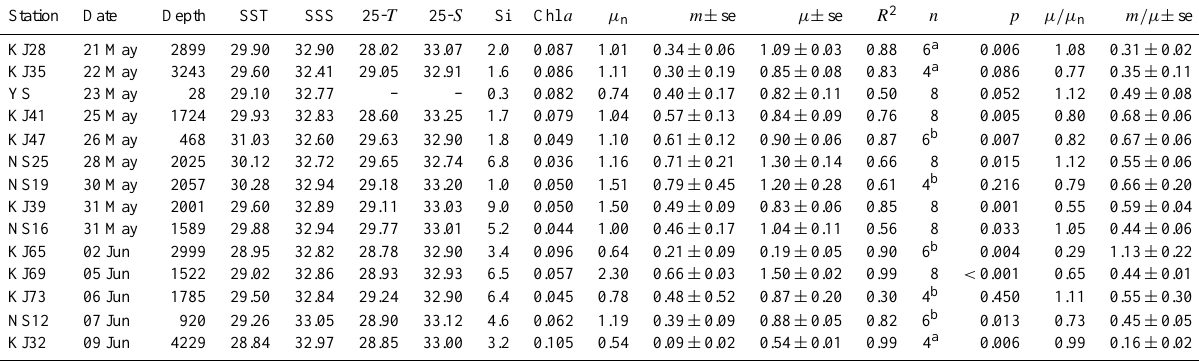
Table 1. Summary of environmental variables, phytoplankton growth rates with ( µ n , d − 1 ) and ( µ , d − 1 ) without nutrient amendment, and microzooplankton grazing rates ( m , d − 1 ) in the southern South China Sea in May–June 2009. SST, surface seawater temperature ( ◦ C); SSS, surface seawater salinity; 25- T ( S ) seawater temperature (salinity) at 25m in depth; Si, silicate (µmolL − 1 ); Chl a , chlorophyll a (µgL − 1 ); n , the number of data points in the linear part; R 2 , the determination coefficient of the regression of the linear part; se, standard error; the superscript “a” denotes a saturated feeding response; the superscript “b” denotes a saturated-increased feeding response. The significant level ( p ) of regressions when saturated or saturated-increased feeding responses occurred was in some occasions > 0.05 owing to the few points included in the regression.